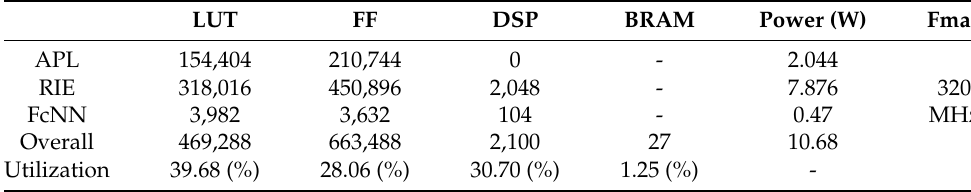
Figure 10. Layout of HARP with four Inference Engines in ASIC using TSMC library at 90 nm technology ( a ) and in the Virtex UltraScale+ FPGA ( b ). Table 4. UltraScale FPGA Resource